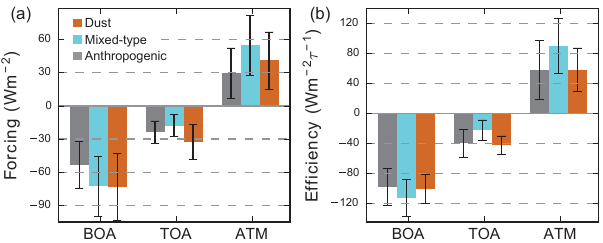
Figure 4. (a) Radiative forcing and (b) radiative efficiency of the dust, mixed-type, and anthropogenic aerosols averaged from East Asian sites.